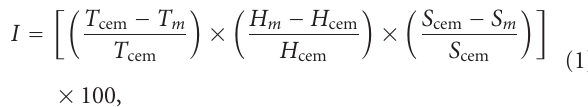
Table 1: Raw material grading according to inhibition index. Inhibition index ( I ) Grading I ≤ 10 Low inhibition 10 < I ≤ 50 Medium inhibition 50 < I ≤ 100 High inhibition I > 100 Extreme inhibition Source: Okino et al.